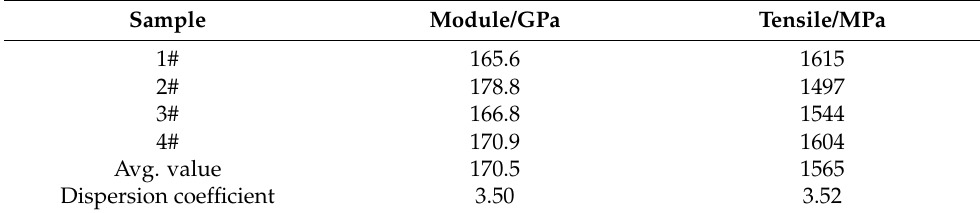
Figure 1. Thread axial tensile stress–strain curve. Table 1. Axial tensile properties of threads.